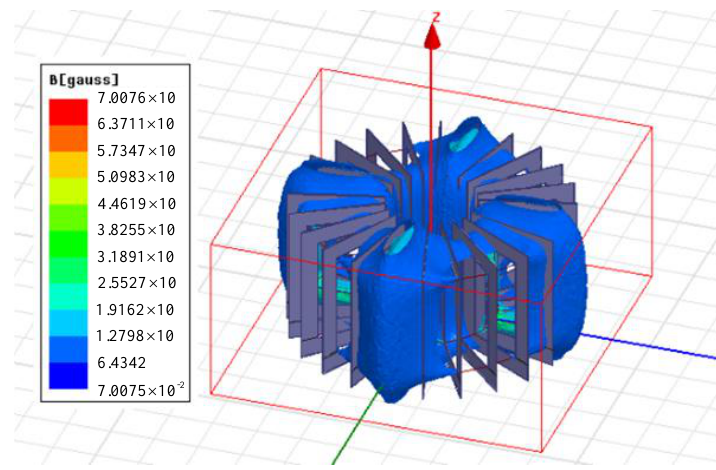
Figure 13. Simulating results of the magnetic flux density of the transformer with sendust ring-core.